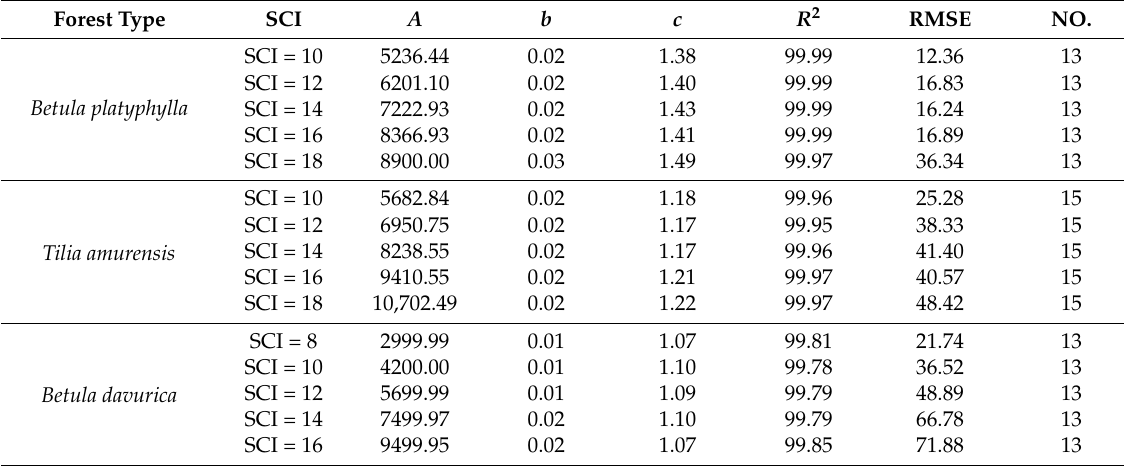
Figure A2. NPP for different age classes (young, mature, and old stands) in two categories of SCI values for the nine pure forest types.